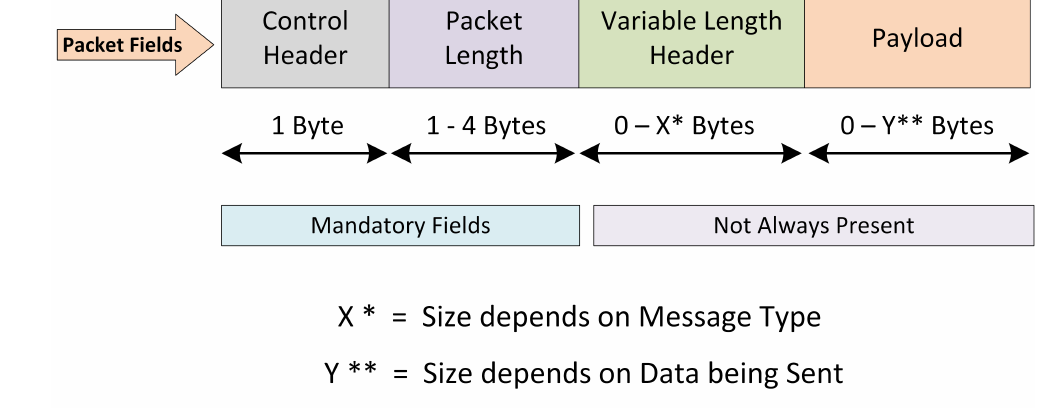
Figure 2. MQTT standard packet